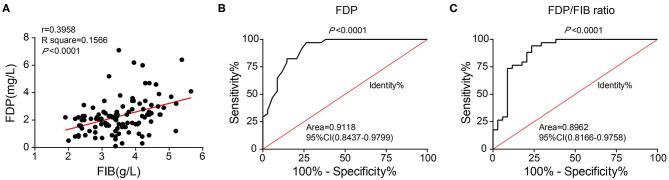
(A) Correlation analysis of FIB and FDP levels showing their positive correlation. (B) ROC curve of FDP as a diagnostic index. (C) ROC curve of the FDP/FIB ratio as a diagnostic index.